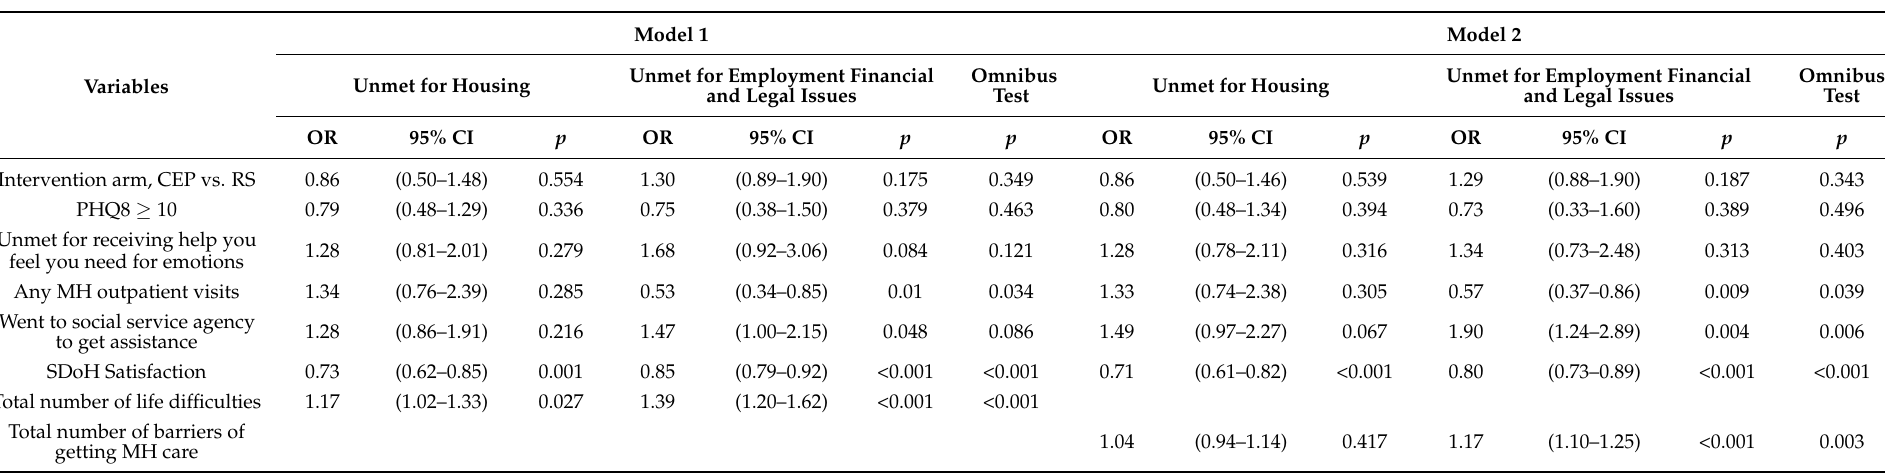
Table A3. Models for perceived unmet needs for housing assistance and employment financial and legal assistance at 36 months, by perceived life difficulties, life satisfaction, barriers to care, and service utilization controlling for intervention condition